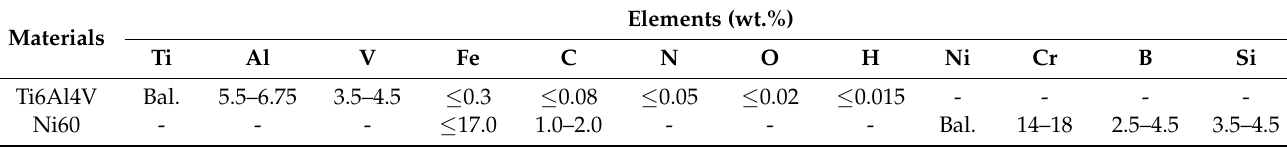
Figure 1. The SEM morphologies of the powders. ( a ) Ti6Al4V, ( b ) Ni60, ( c ) Ni-MoS 2 . Table 2. The chemical compositions of Ti6Al4V and Ni60.